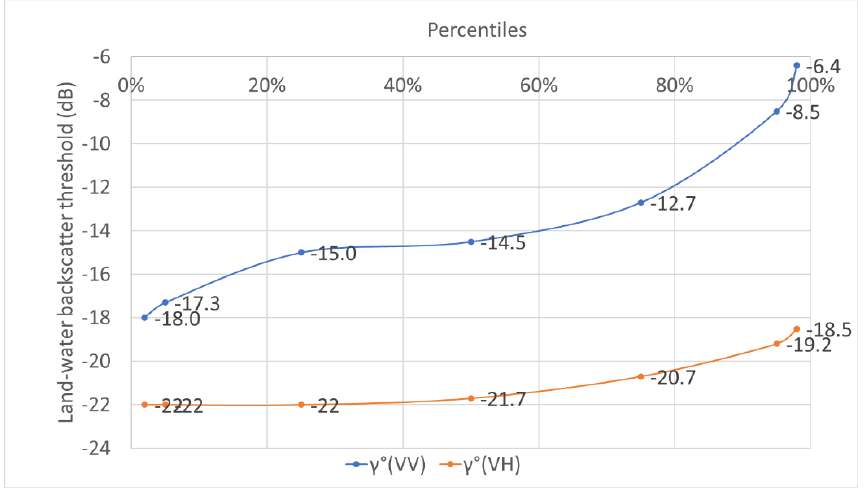
Figure 7. Land – water threshold vs. percentile backscatter image of both polarizations: VV and VH.